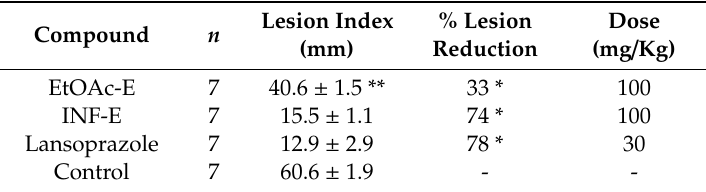
Table 1. Gastroprotective effect of the organic (EtOAc-E) and edible extract (INF-E) on HCl / EtOH-induced gastric lesions in